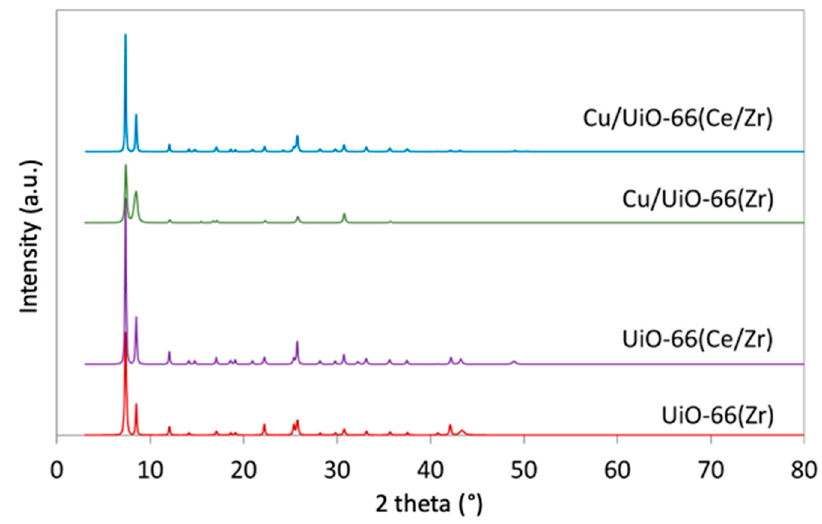
Figure 2. XRD for UiO-66 and Cu/UiO-66 materials.